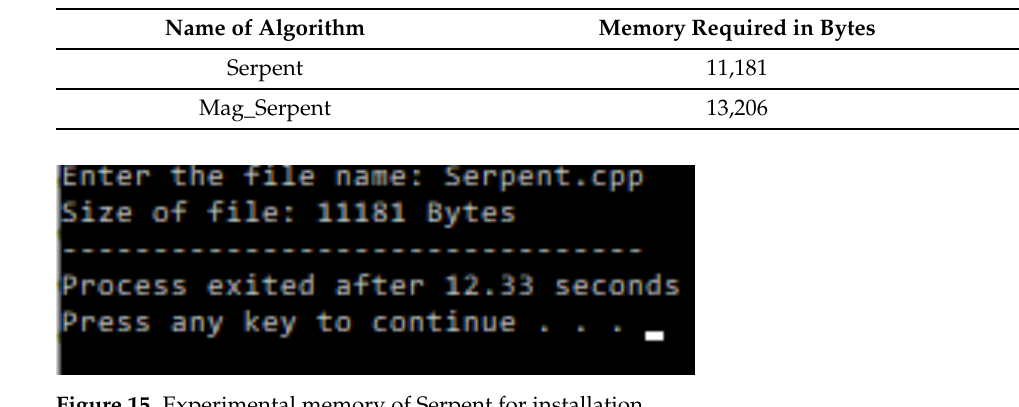
Table 22. Memory required for installation of algorithms.